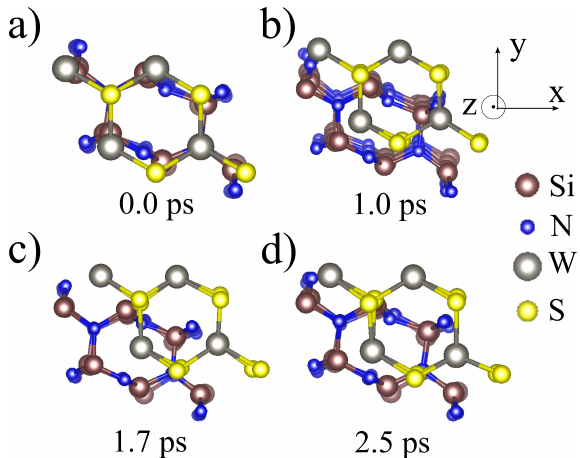
Figure 3. Snapshots from Nosé-Thermostat molecular dynamics of 1L-WS 2 over Si 3 N 4 substrate stacked in a AA pattern, as shown is ( a ). Along the MD evolution, the 1L-WS 2 slowly deviates from AA stacking towards the AB, as featured in ( b , c ). The heterojunctions reach an energy minimum at 2.5 ps, as depicted in ( d ), remaining on this site for the rest of the simulation, allowed to run for over than 3.0